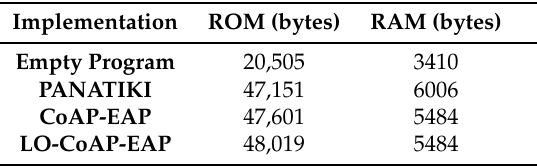
Table 7. Memory footprint of the implementations in Cooja.